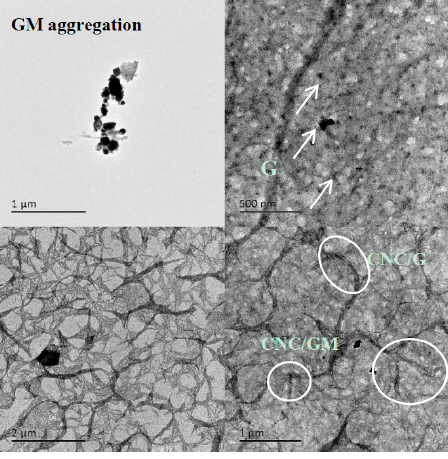
/ GM sol mixtures containing 2 wt % of Figure 5. TEM images of GM and CNC/GM sol mixtures containing 2 wt % of GM. Figure 5. TEM images of GM and CNC Figure 5. TEM images of GM and CNC/GM sol mixtures containing 2 wt % of GM.